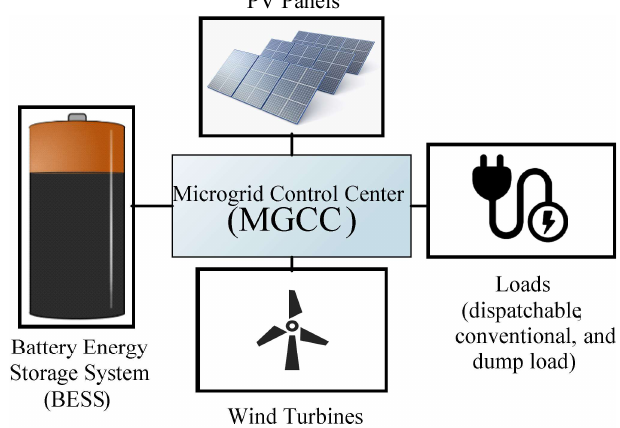
Figure 1. Structure of studied microgrid.